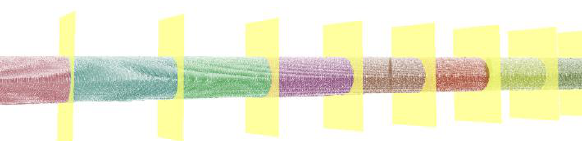
Figure 7. Point cloud classified by axis segment (limited by yellow plans).